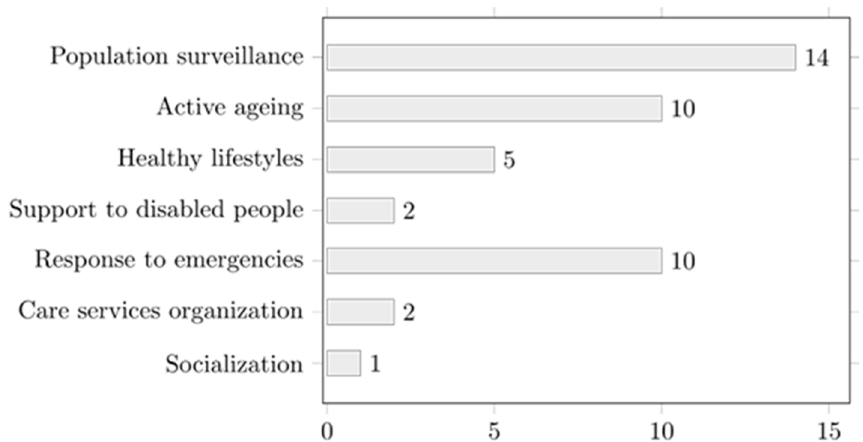
Figure 2. Number of articles per application domain.